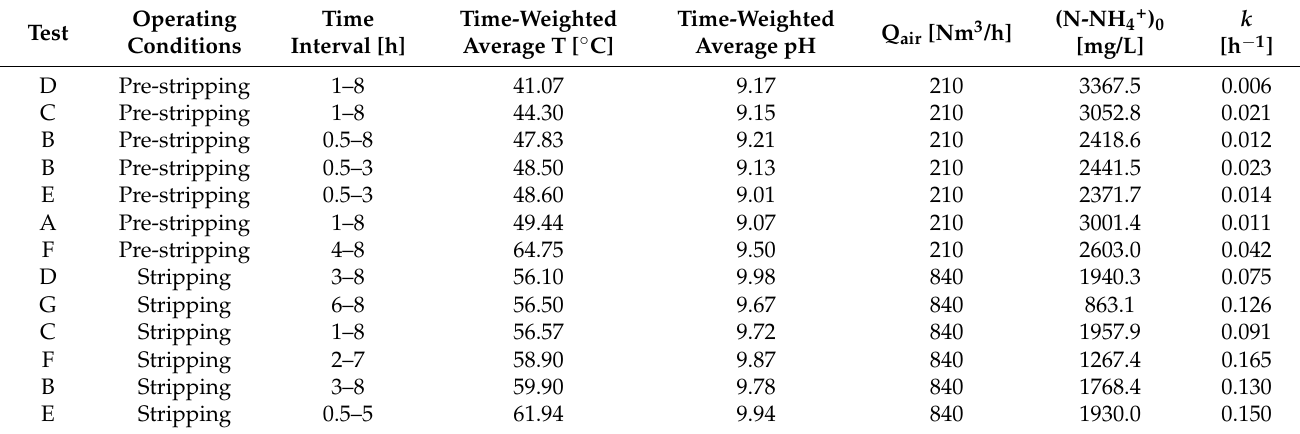
Table 4. Results of the mathematical model: kinetic constant and initial concentration of ammoniacal nitrogen for each identified time interval in the